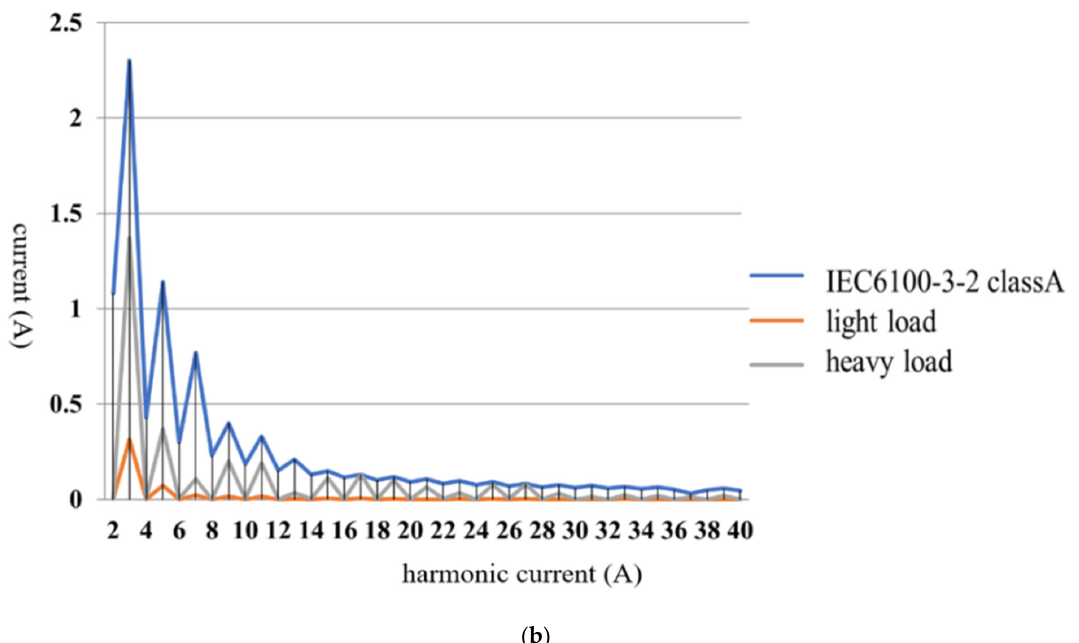
Figure 15. Plots of harmonic current of the proposed interleaving bridgeless boost converter from light load to heavy load ( a ) under input voltage of 110 V, and ( b ) under input voltage of 220 V.